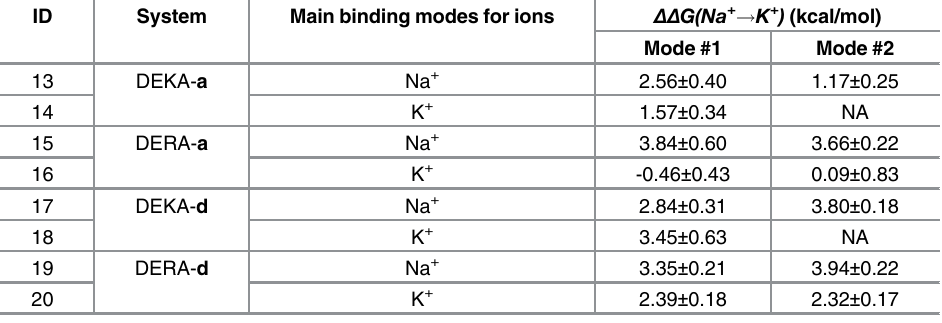
In each case, the calculation was repeated for three times to estimate the mean and standard deviation. The original data for this table are listed in Table J in S1